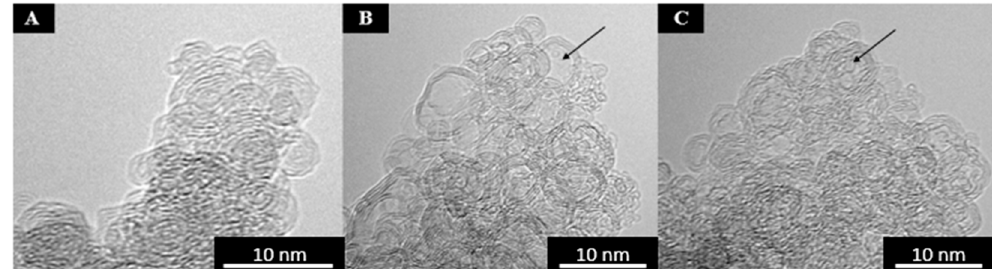
Figure 15. TEM micrographs of sucrose char after 5 s at 2600 °C. ( A ) Stage tilt: − 45 ° ; ( B ) stage tilt 0°, ( C ) and stage tilt 45°.